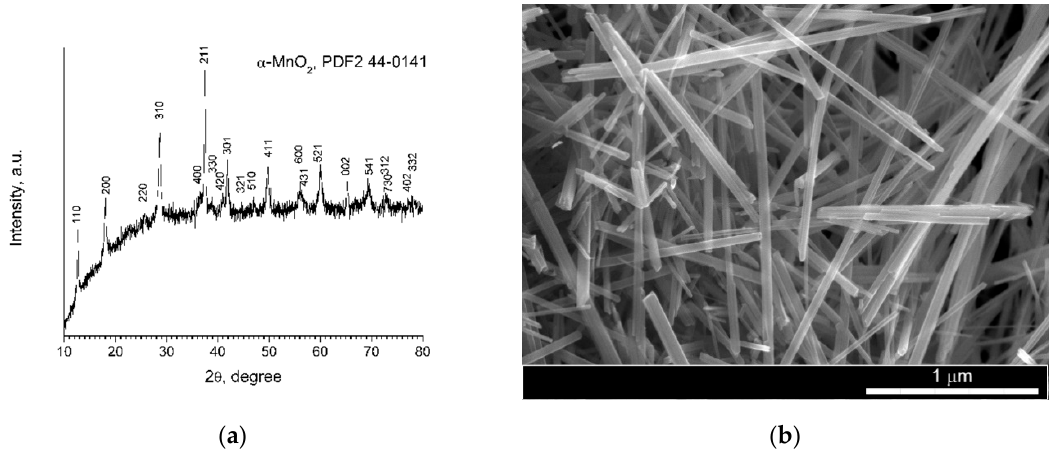
Figure 1. Results of ( a ) X-ray powder diffraction (XRD) and ( b ) SEM of α -MnO 2 powder used as a filler for polydimethylsiloxane elastomer.